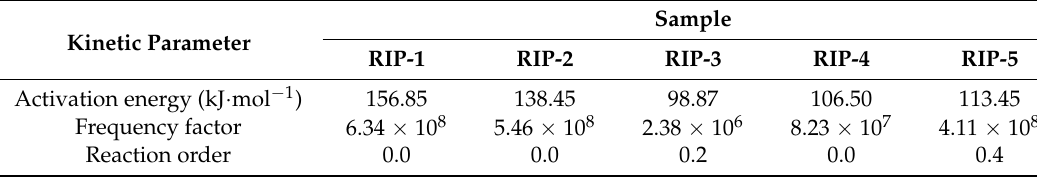
Figure 4. Dynamic thermogravimetric curves of riparin batches at the heating rate of 10.0 ◦ C · min − 1 . Table 1. Kinetic parameter from the dynamic TG data for riparin batches in the decomposed fraction α 10 obtained using the Ozawa method.